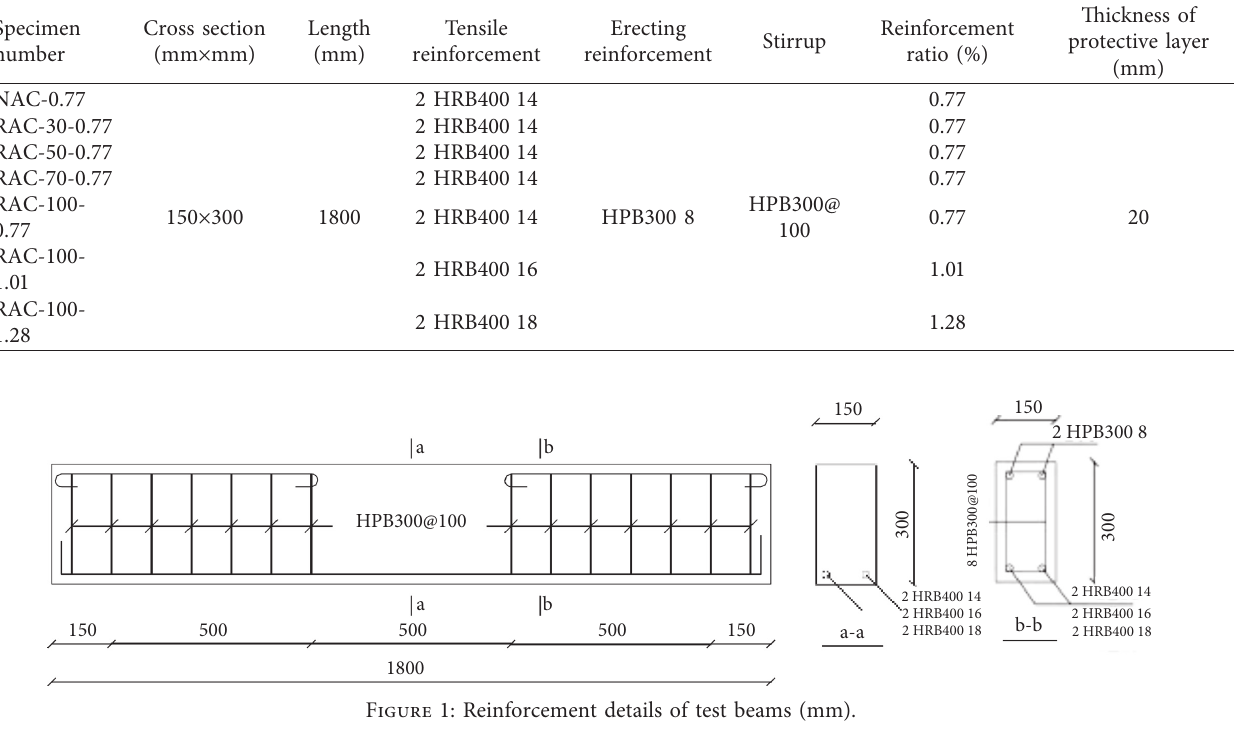
Table 5: Design parameters of test